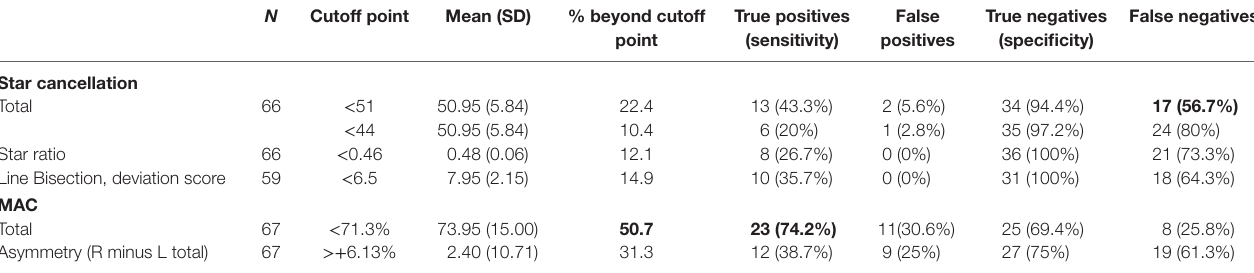
TaBle 2 | Number of true/false negative/positive calculations for the Star Cancellation using the star ratio and two laterality indexes ( < 44, < 51), the Line Bisection—deviation score, and the MAC total score and asymmetry cutoffs derived from the control data . N